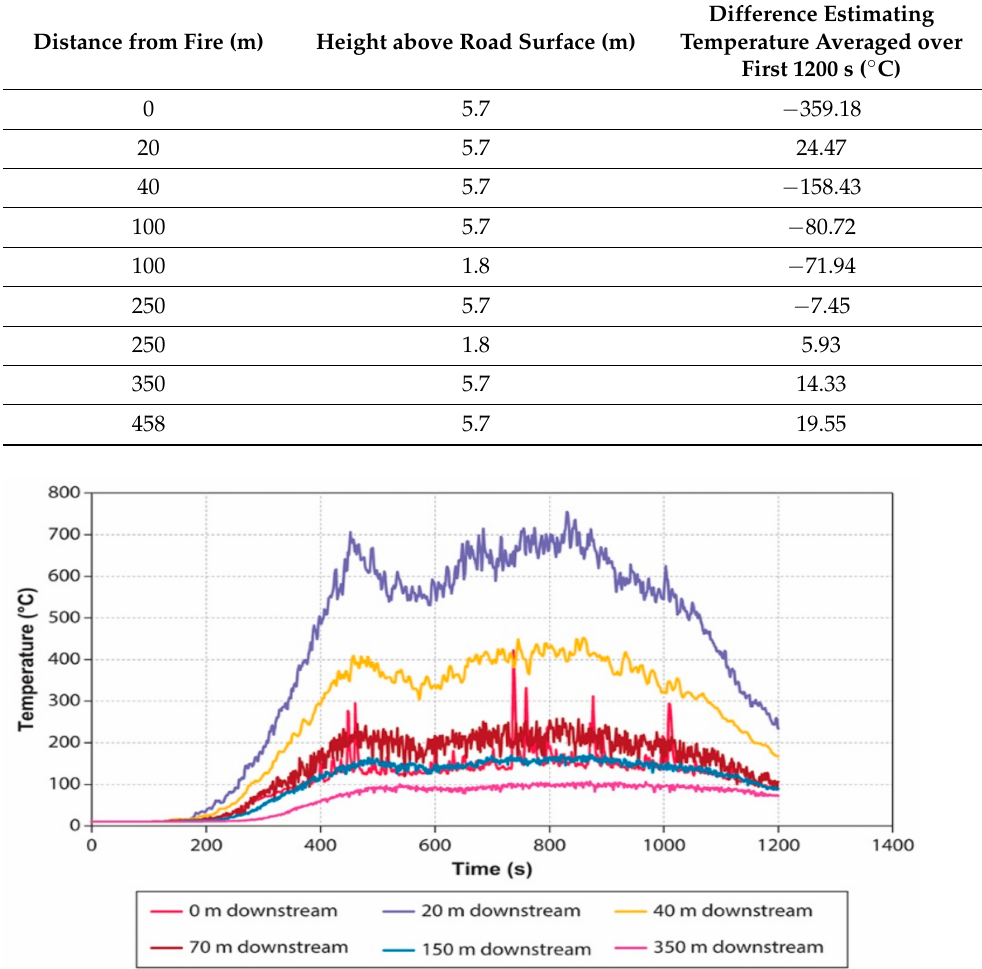
Figure 6. Gas temperature, 50 cm below the